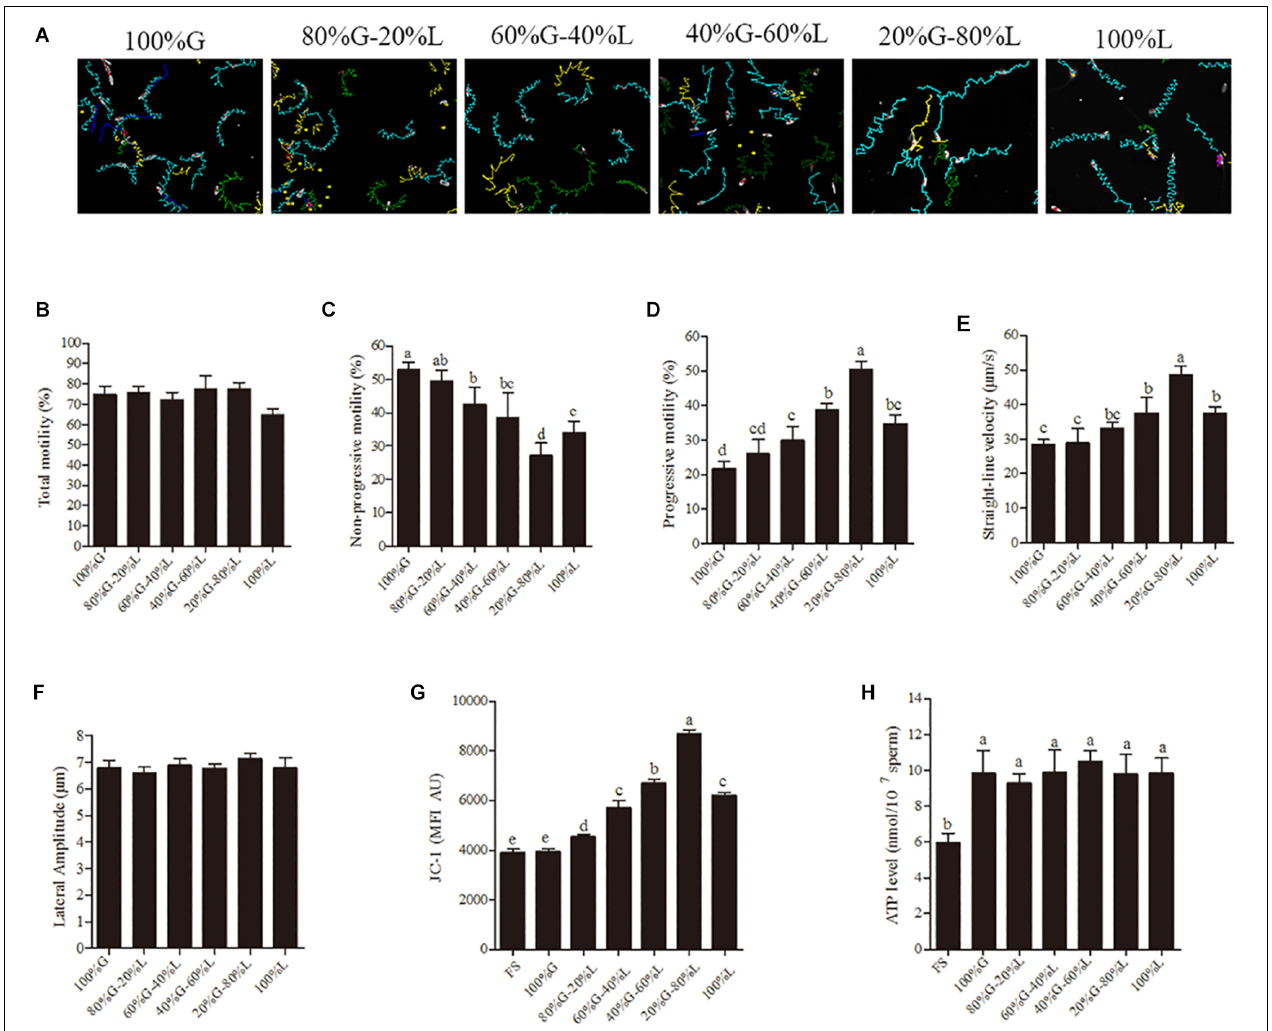
FIGURE 1 | Low glucose condition improves the sperm motility patterns through enhancing the mitochondrial activity at 1 h of incubation. (A) CASA derived changes in the sperm motility track from circular to linear by reducing the glucose level from 153 mM to 0 mM (namely 100–0%). (B–F) Dynamic changes in the sperm parameters: (B) total motility, (C) non-progressive motility (D) progressive motility, (E) straight-line velocity and (F) lateral amplitude. (G) Kinetic changes in the mitochondrial activity. (H) ATP level in the sperm. Values are specified as mean ± standard error of mean (SEM) of three replicates. Columns with different lowercase letters differ significantly ( p < 0.05). The letters in X -axis are symbolized as – G, glucose; L, lactose; FS, fresh